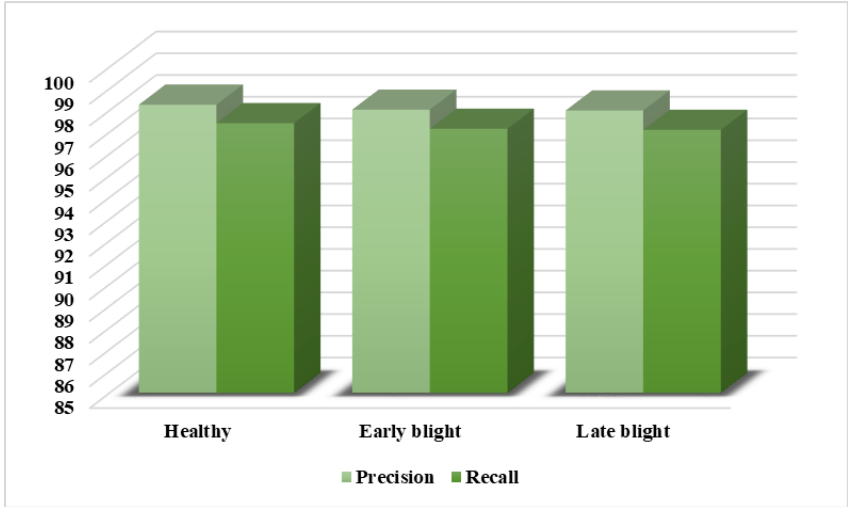
Figure 6. A graphical depiction of the attained precision and recall results.